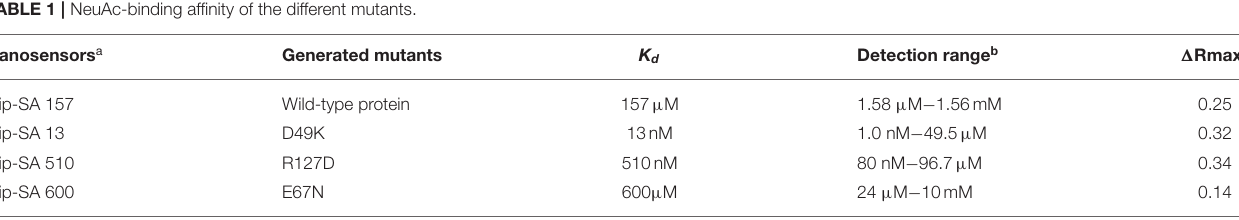
TABLE 1 | NeuAc-binding affinity of the different